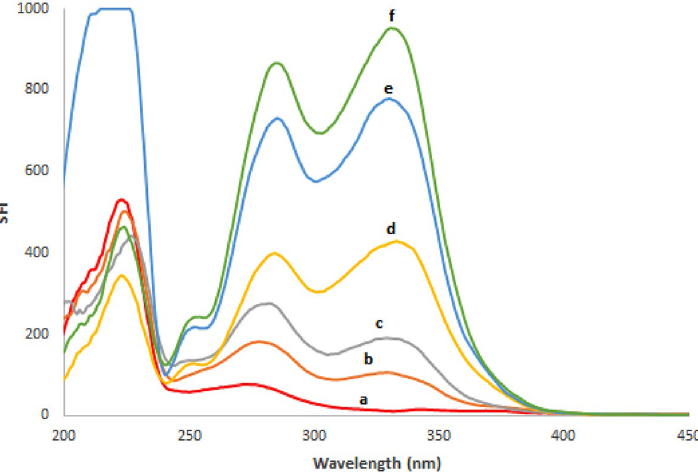
Figure 7. Application of drugs in spiked human plasma where: (a) Blank (Plasma). (b–f) concentration of drugs spiked in plasma samples (0.10, 0.20, 0.40, 0.80, 1.00 μg/mL) for each of REM and SIM, respectively.